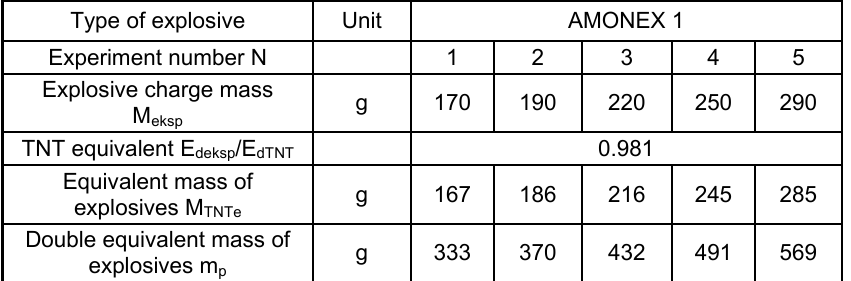
Table 2 – Explosive charge mass and the equivalent mass of AMONEX 1 Таблица 2 – Масса заряда взрывчатого вещества и эквивалентная масса AMONEX 1 Табела 2 – Маса експлозивног пуњења и еквивалентна маса AMONEX